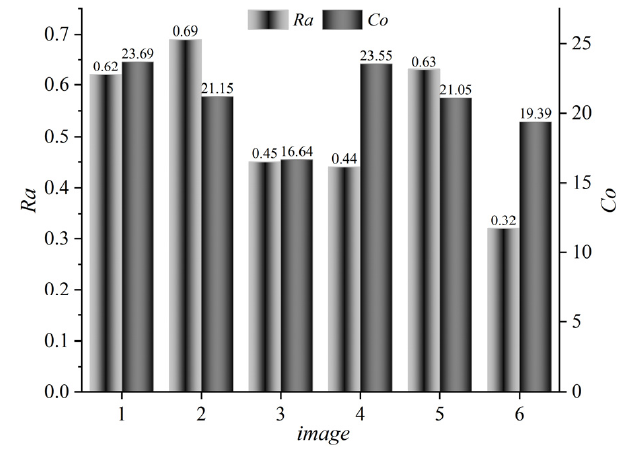
Figure 12. Subjective comparison of sample attention point classification results.